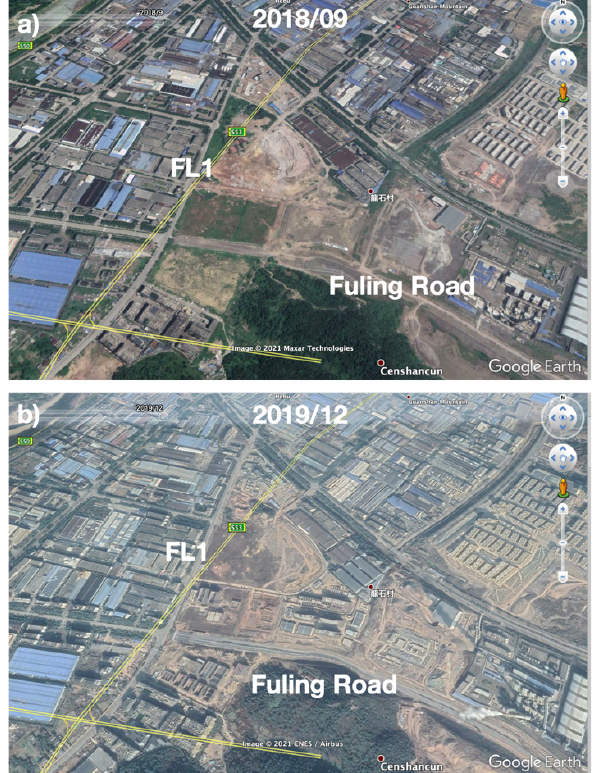
Figure 4 . Google Earth TM images of FL1 acquired at Sep. 2018 and Dec. 2019.